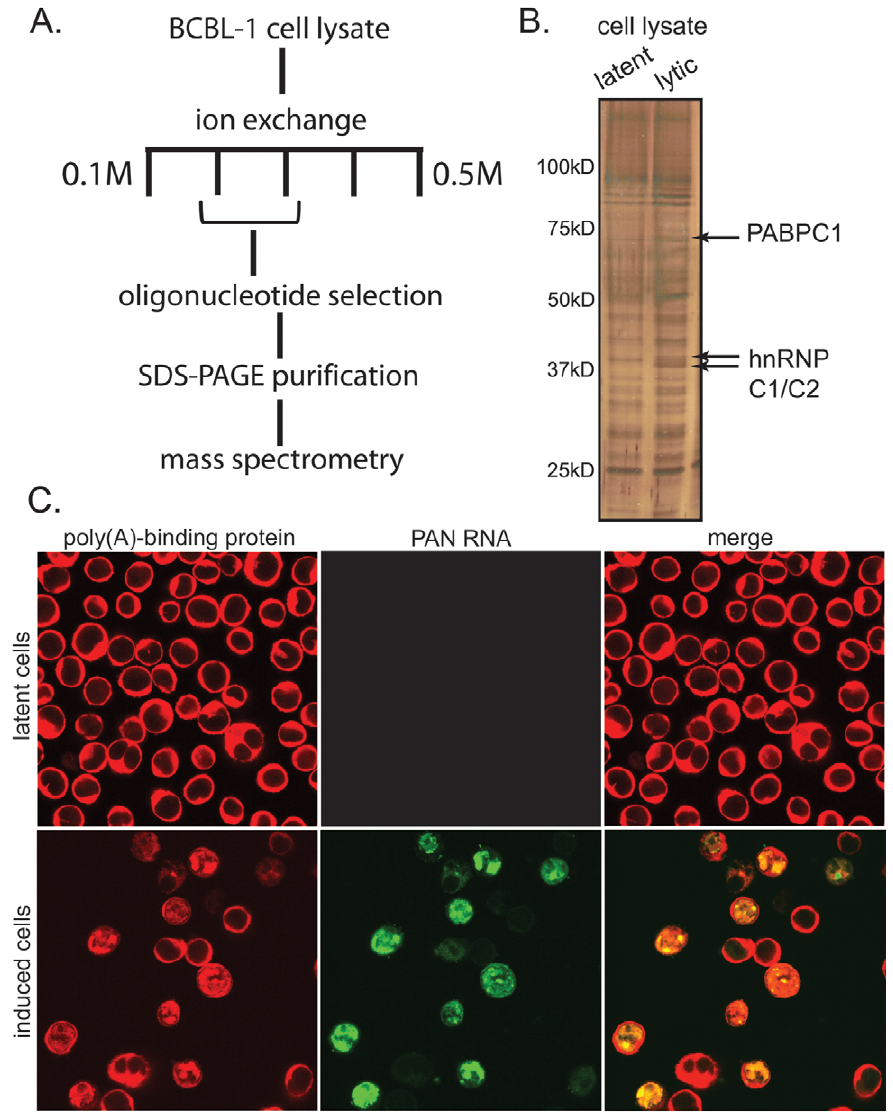
Figure 1. PAN RNA binds to PABPC1 in the nucleus of lytically infected BCBL1 TReX-RTA cells. A. Scheme for biochemical purification of the PAN RNP. B. 10% SDS-PAGE gel silver-stained to show proteins co-purifying with PAN RNA from lysates of doxycycline-treated BCBL1 TReX-vector cells (left lane) or BCBL1 TReX-RTA cells (right lane). C. Dual immunofluorescence and in situ hybridization for PABPC1 (red) and PAN RNA (green) from BCBL1 TReX-vector cells (top panels) or BCBL1 TReX-RTA cells (bottom panels) treated with